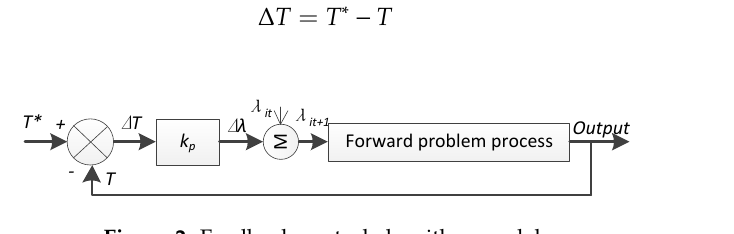
Figure 2. Feedback control algorithm model.